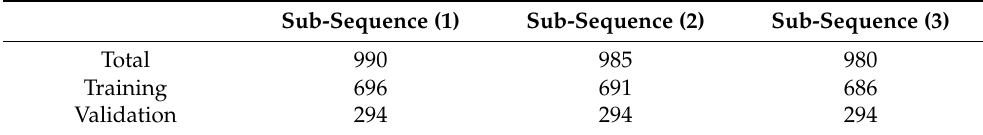
Table 2. Number of training and validation datapoints.